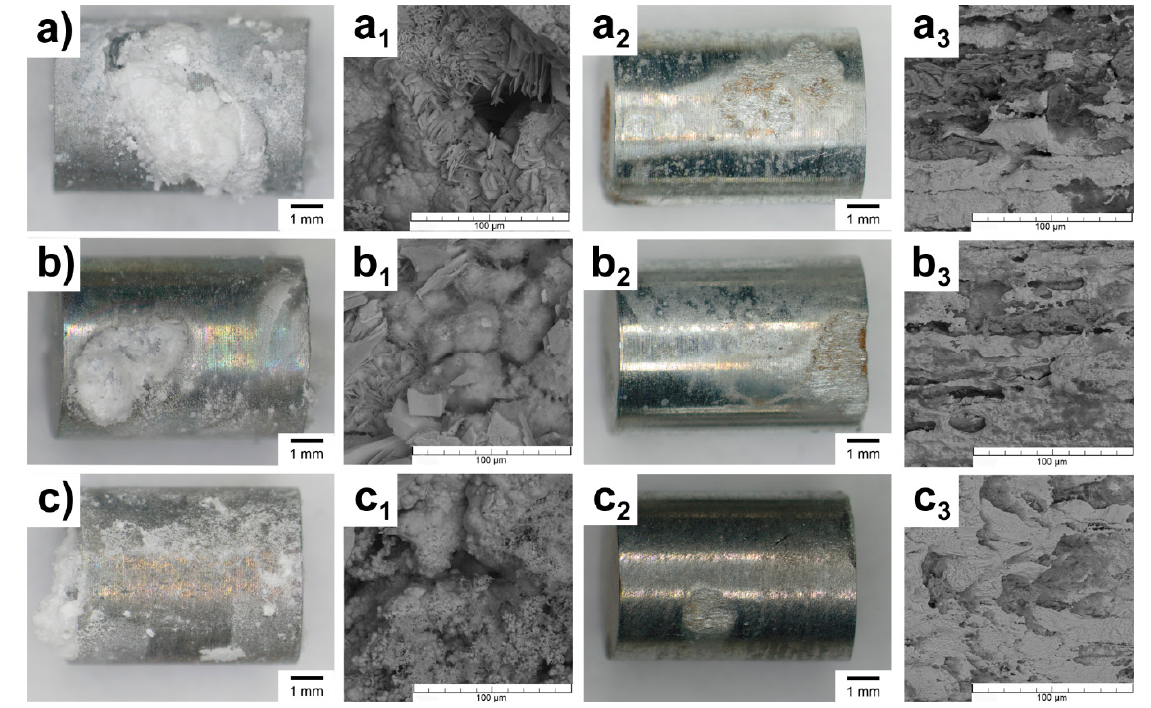
Figure 6. Surface morphology of ( a ) Zn-4MO, ( b ) Zn-4HA and ( c ) Zn-8HA samples after the exposition ( a 1 – c 1 ) in SBF and after the chemical removing of corrosion products ( a 2 – c 3 ). Table 6. Corrosion rates of the composites evaluated by weight loss and ion release.